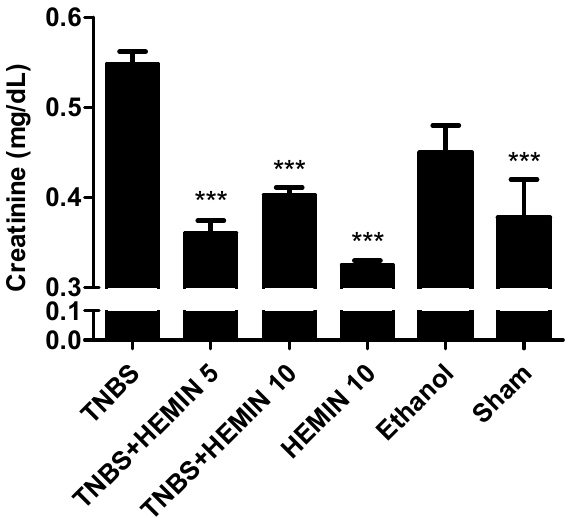
Figure 9. Effect of hemin treatment on creatinine concentration in the IBD. Legend: One-way ANOVA for multiple comparisons and Tukey’s post hoc test. *** p < 0.001; compared with TNBS group.